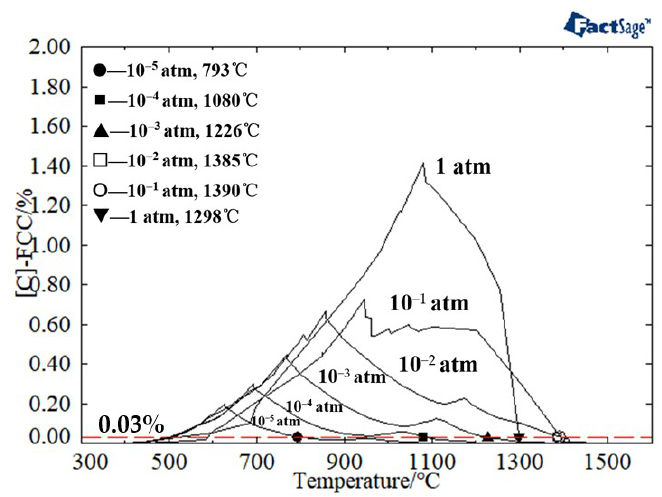
Figure 6. Carbon content in FCC under different system pressure.